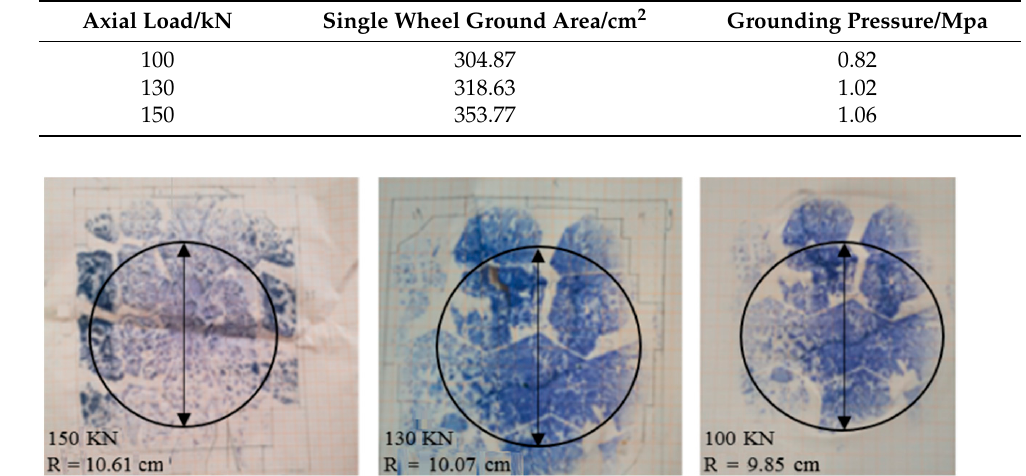
Figure 4. Diagram of wheel ground area. Table 4. Wheel ground area under different ground